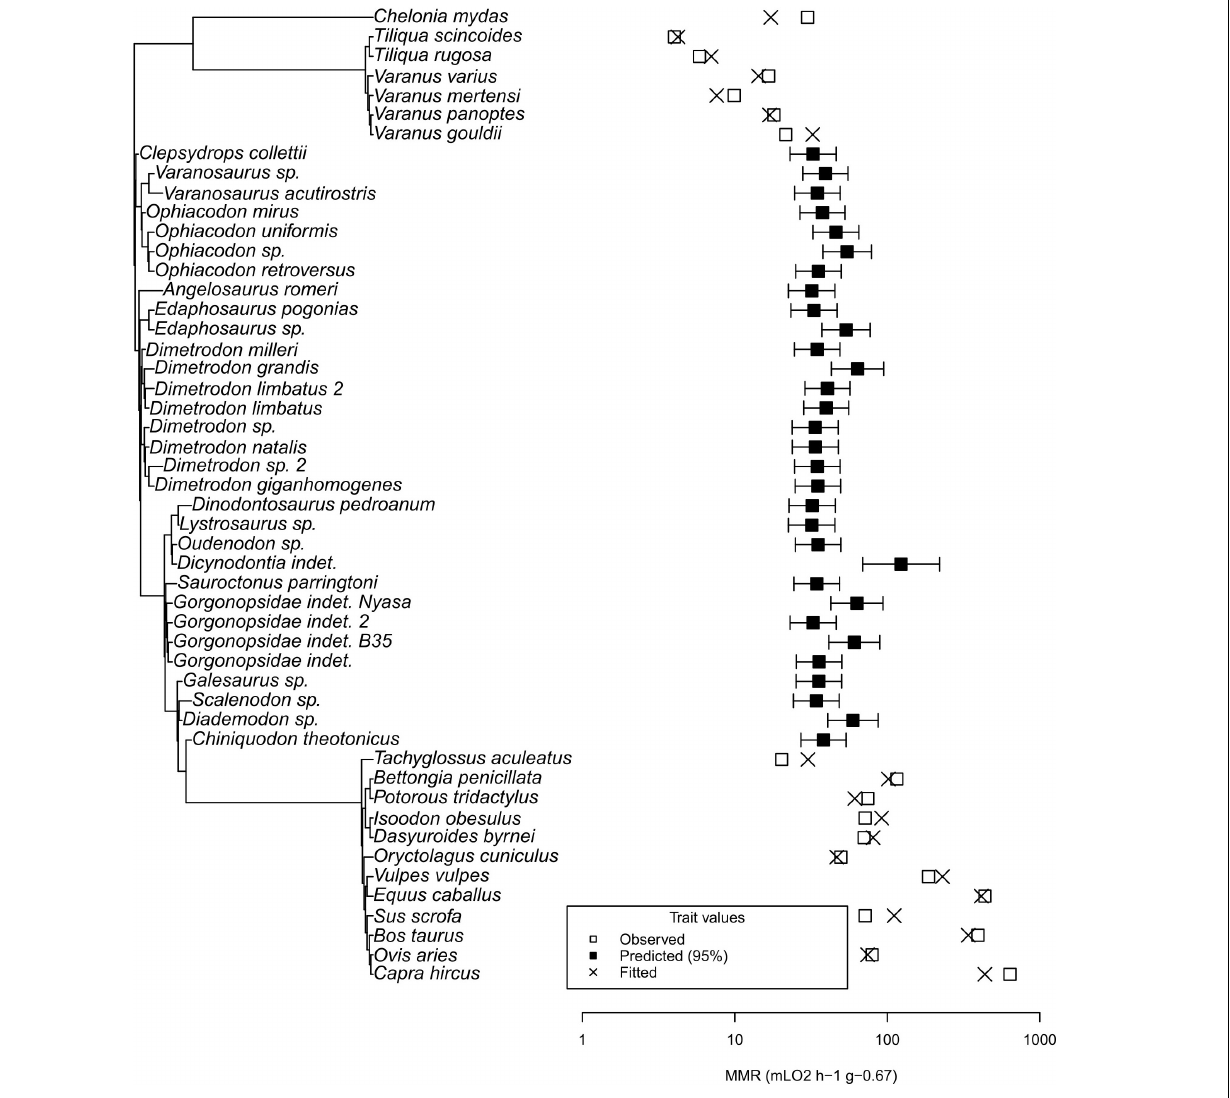
FIGURE 6 | Phylogenetic tree and plot of maximum metabolic rates for recent taxa with MMR data and fossil taxa. Note that the predicted values for fossil non-mammalian synapsids are above non-varanid ectotherms and overlap with recent mammals, comparable to varanids and the echidna Tachyglossus